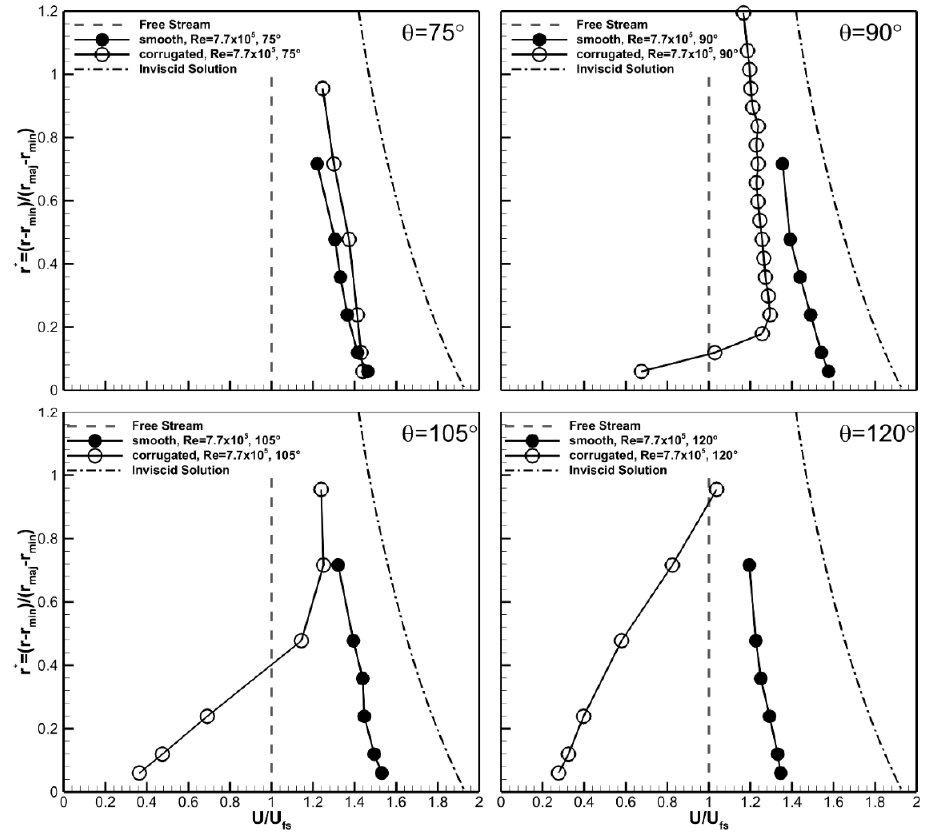
Figure 15. V θ velocity profiles normal to the surface. Angular position as indicated. Re = 7.7 × 10 5 .